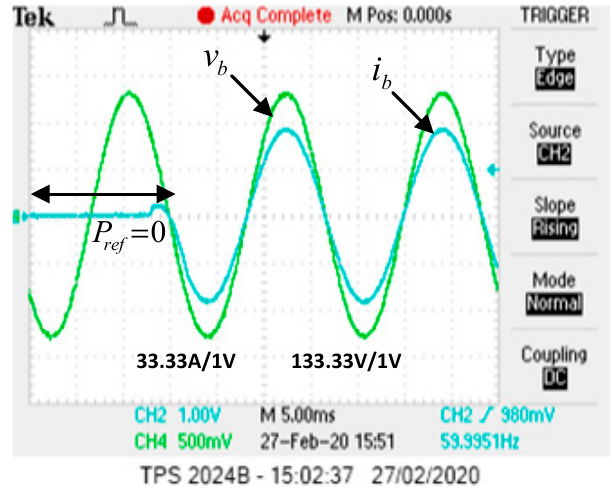
Figure 8. Voltage and current for phase A during Pref = 0 to Pref = 10 kW and Qref = 0.